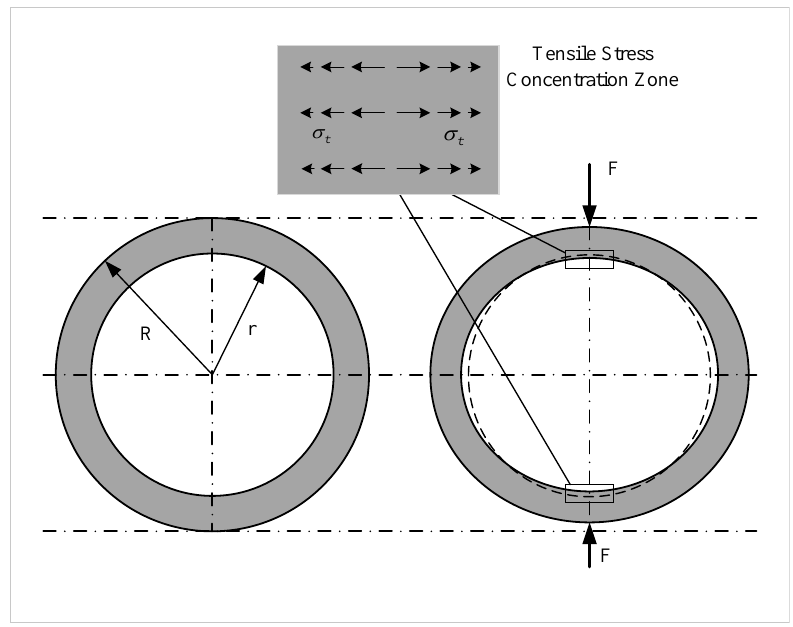
Figure 1. Diagram of ring structure deformation under radial